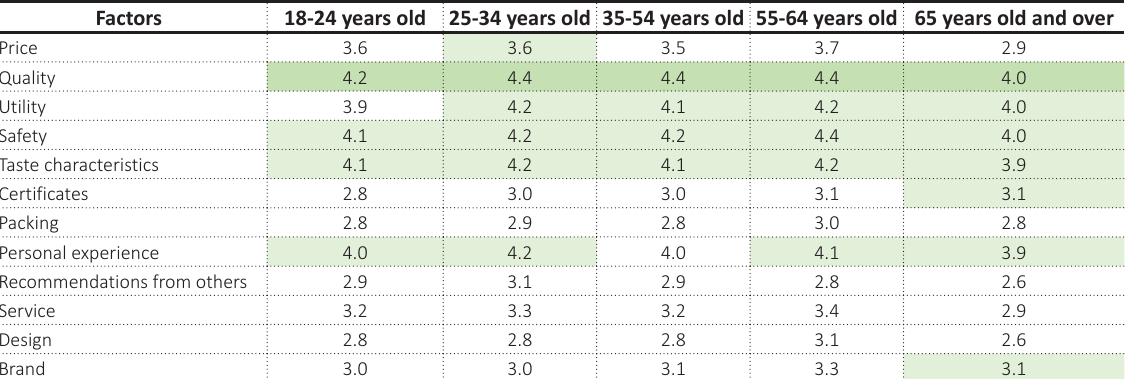
Table 4. Results to the question: Please, rate the following factors according to their importance in choosing agri-food products with scores (1 – the lowest, 5 – the highest). Seen in terms of age (average score)